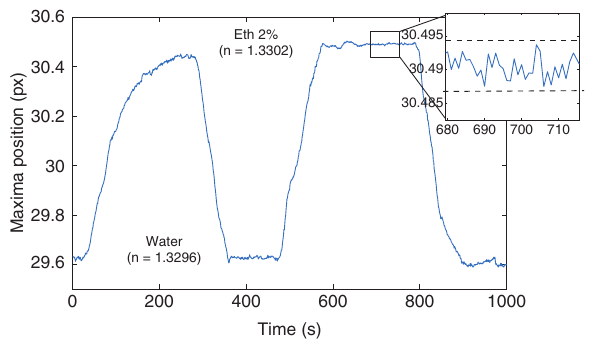
Figure 5: Limit of detection measurements. Real-time measurements of the position of the resonance maxima for different concentration of ethanol in